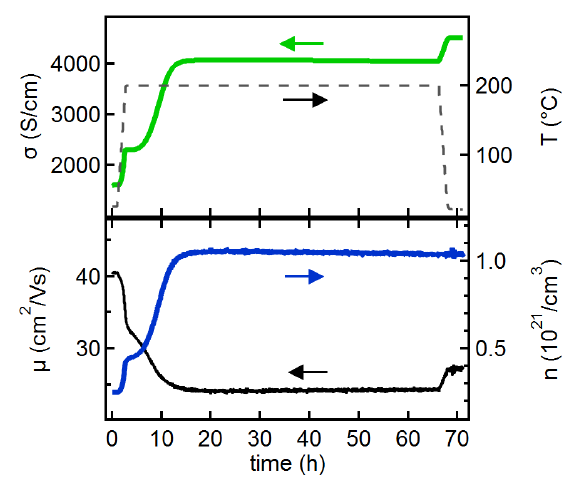
Figure 5. Conductivity and Hall effect measurements during extended annealing of a 10nm-thick ITO film deposited at room temperature in